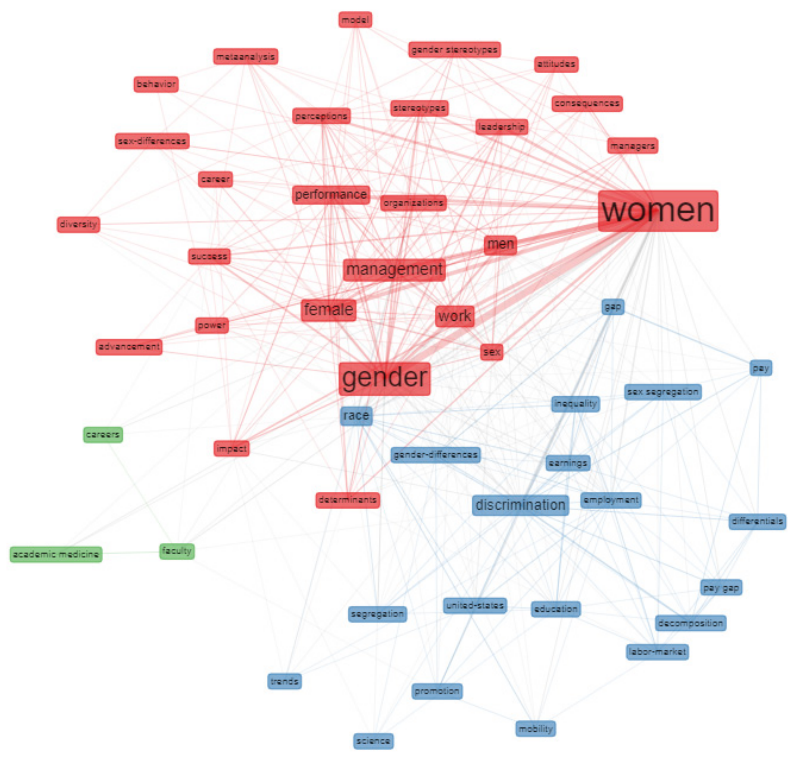
Figure 7. Co-occurrence